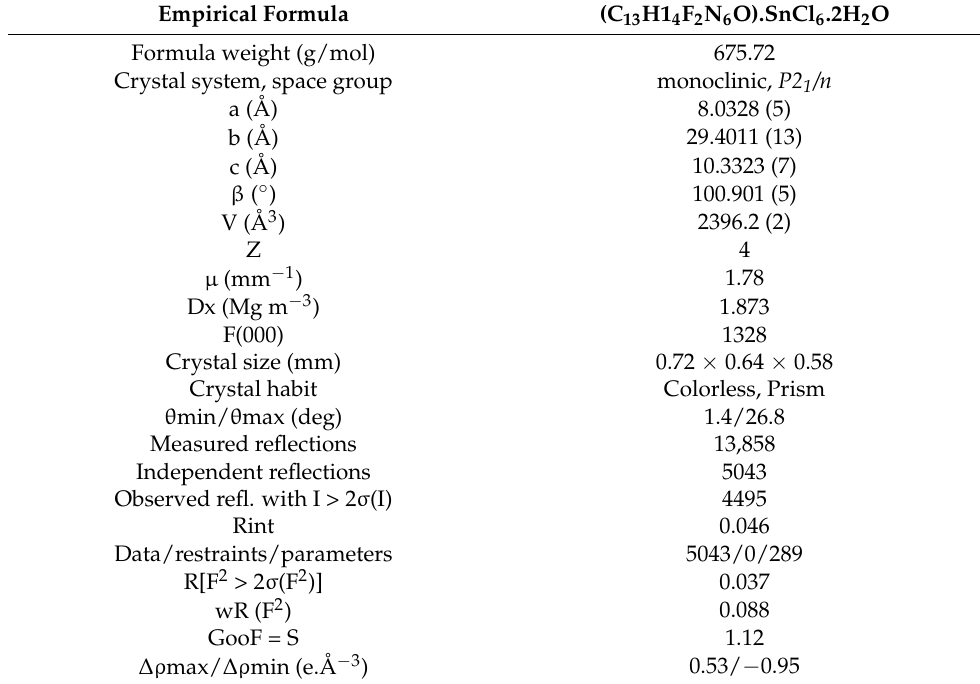
Table 1. Crystallographic data and structure refinement parameters of (H2Fluconazole).SnCl 6 .2H 2